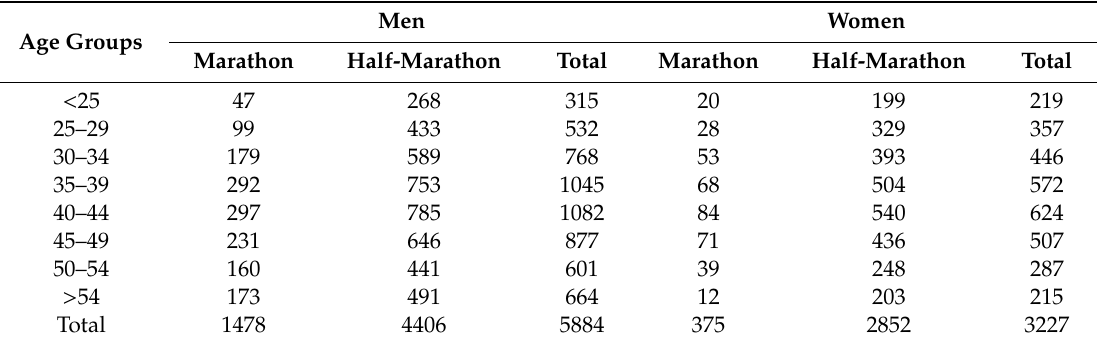
Table 1. Distribution of men and women in each race and age group.